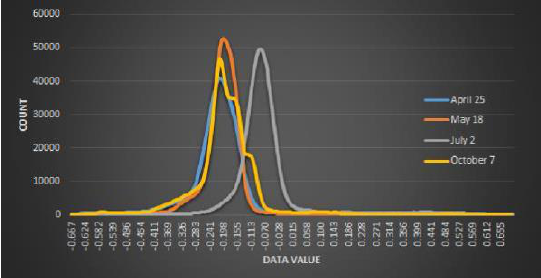
Figure 5. Histogram of NDVI (Normalized Difference Vegetation Index) values